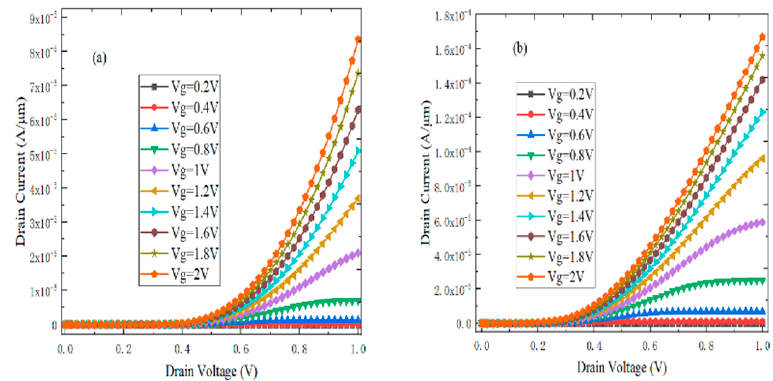
Figure 3. Output characteristics: ( a ) the DLTFET and ( b ) the H-DLTFET at different gate voltages.